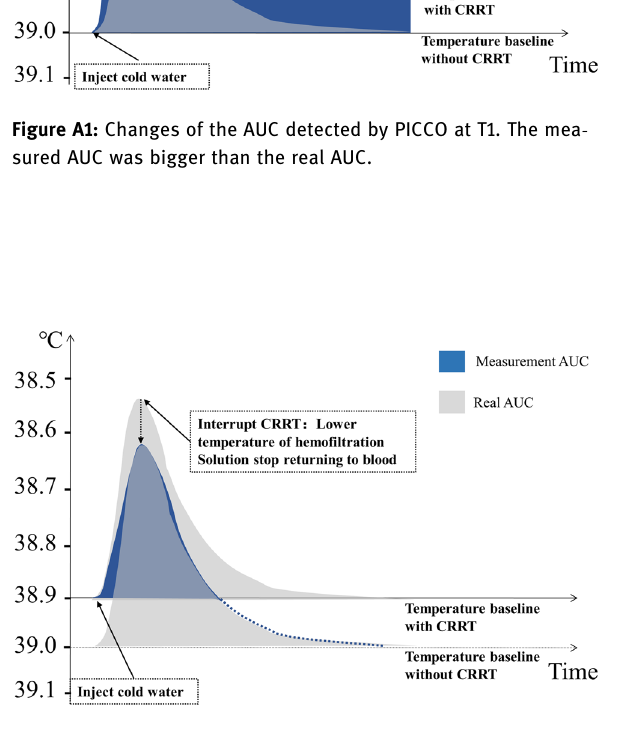
Figure A2: Changes of AUC detected by PICCO at T3. The measured AUC was smaller than the real AUC.